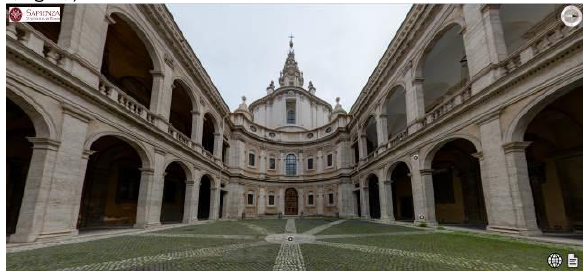
Figure 2. Panotour with hotspots to architectural 3Dmodels near to the S. Ivo church façade, four more sets were positioned at west in the court, near to the main entrance, each one planned to be in direct visual contact with some lateral spans, where additional shooting sets (both types: 360° Figure 1. Topographic and GNNS survey